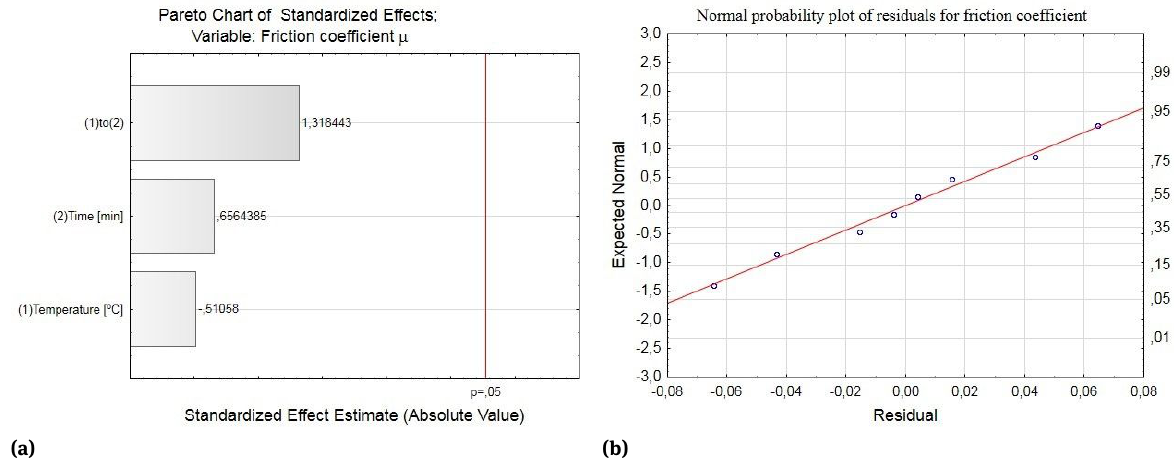
Figure 9: a) The Pareto chart of standardized effects for friction coeflcient µ , b) the graphs of the normal probability plot of residual for friction coeflcient µ variable